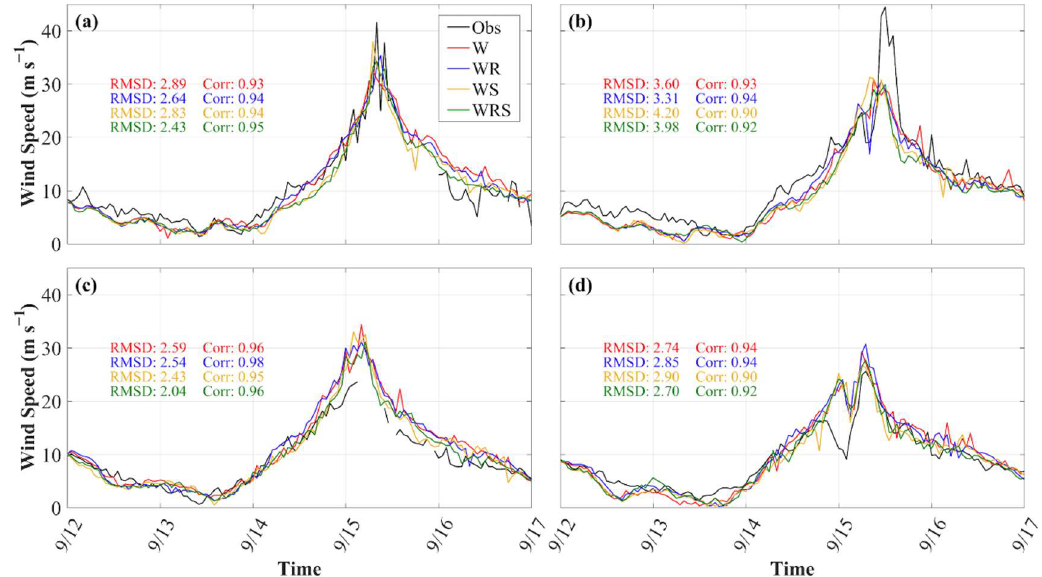
Figure 7. Comparison of observed and simulated 10-m wind speed (m s − 1 ). ( a ) Buoy 1; ( b ) Buoy 2; ( c ) Buoy 4; and ( d ) Buoy 5. Observation (black), W (red), WR (blue), WS (orange) and WRS (green). The same colors are used for RMSD and R 2 , which are calculated relative to observation.